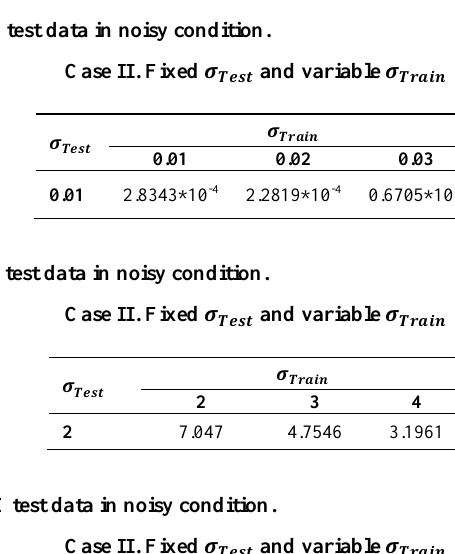
Table 6. MSE of model for CO test data in noisy condition.